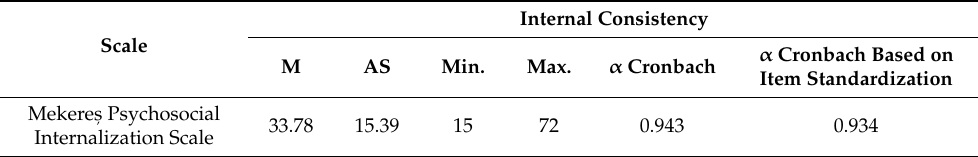
Table 6. Fidelity of the Mekeres